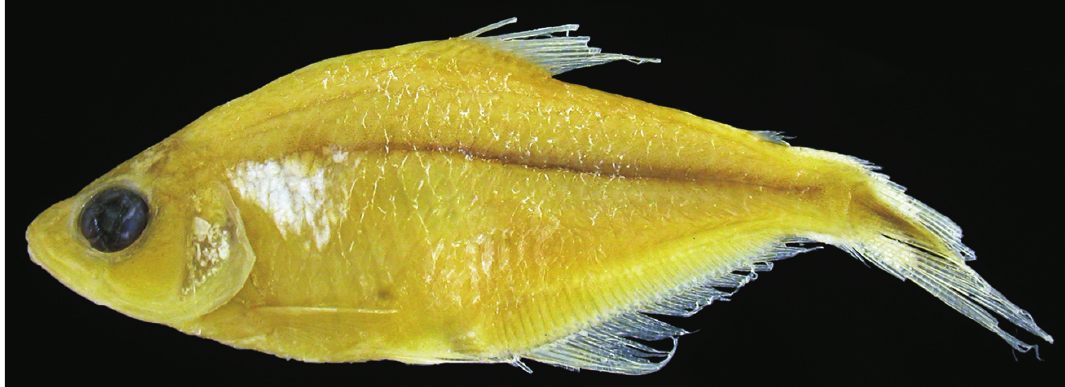
Figura 6. Phenacogaster ojitatus sp. nov. , MZUSP 30551, holótipo, 36,3 mm CP, Rio Curuá, Pará.